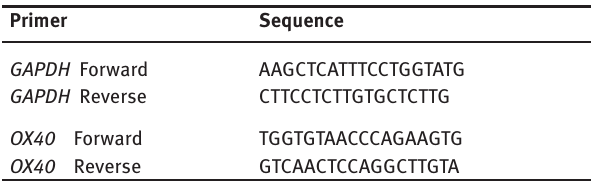
Table 2: Real-time quantitative PCR primers used in the